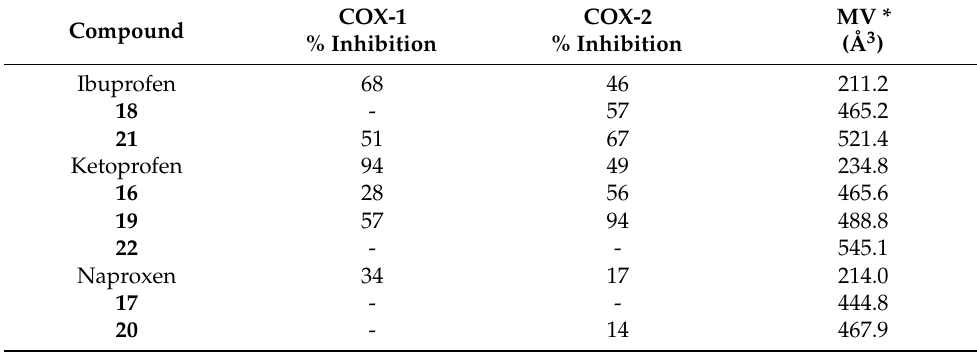
Table 3. Effect of compounds on cyclooxygenase (COX)-1 and -2 activity and their molecular volume